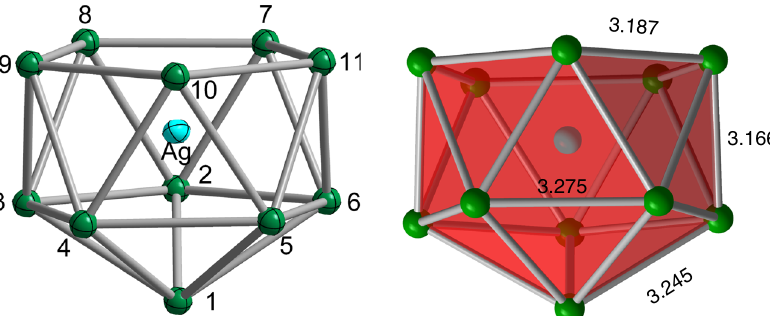
Fig. 2 Structure of the [Ag@Pb 11 ] 3 − anion in 1. The bond lengths are the average of all symmetry-related Pb – Pb distances. Thermal ellipsoids are set at 50% probability level.